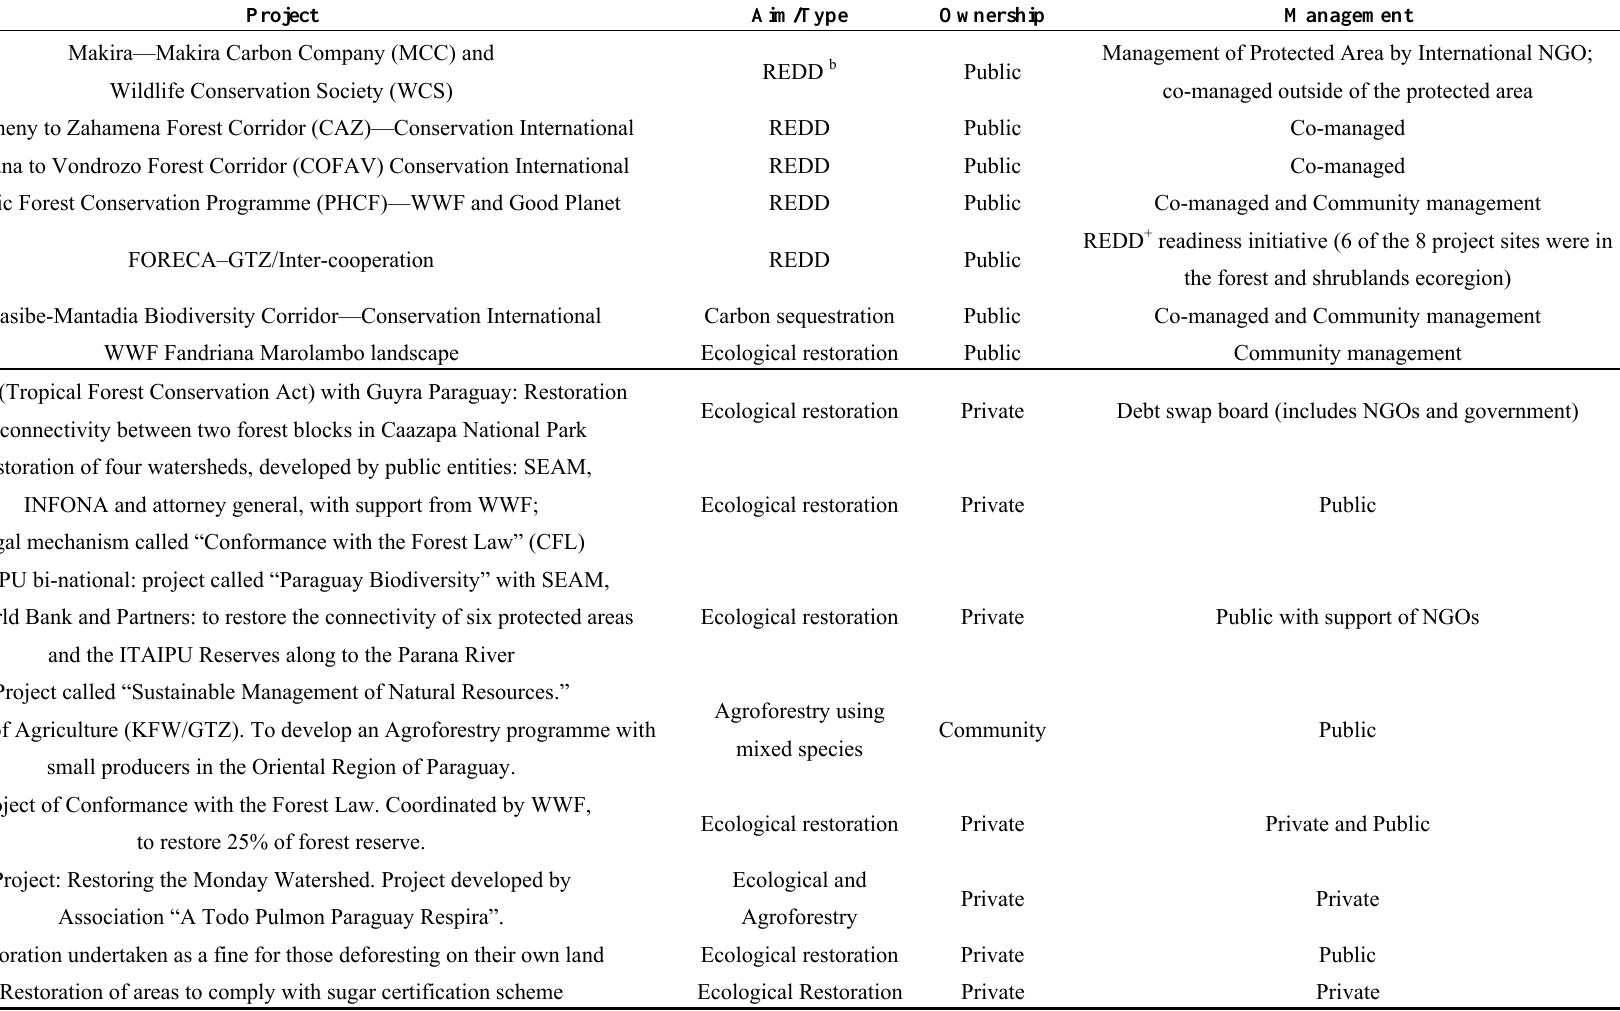
Table 3. Projects involving restoration/reforestation for different objectives a